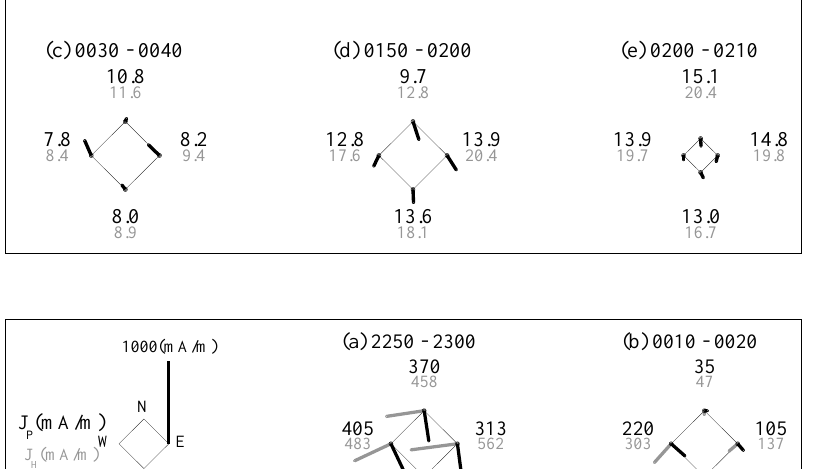
Fig. 6. Spatial variations of the cal- culated height-integrated Pedersen and Hall currents, assuming that both of the conductance and the electric field are measured on the same magnetic field line. Each thick (thin) line indicates the strength and direction of the Pedersen (Hall)